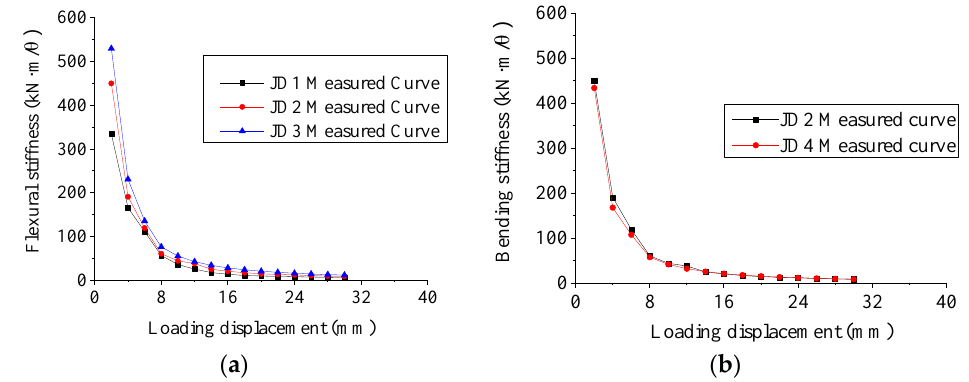
Figure 14. Loading displacement–flexural stiffness curve of semi-fixed dowel joint. ( a ) Wall thick– ness of rubber sleeve. ( b ) Thickness of rubber pad.